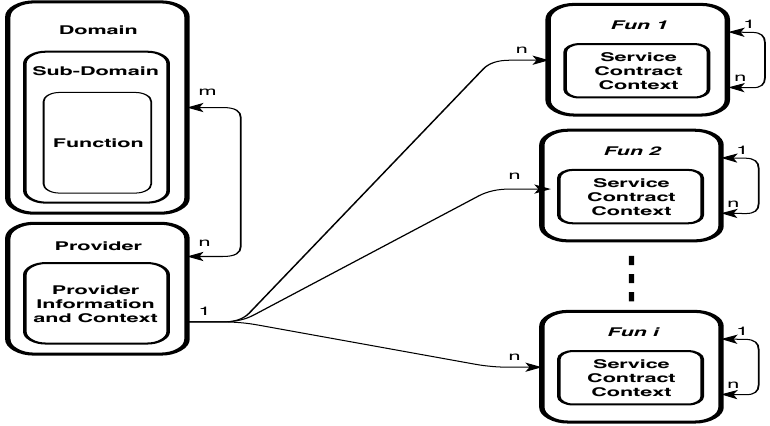
Figure 4. Smart City General Database of the